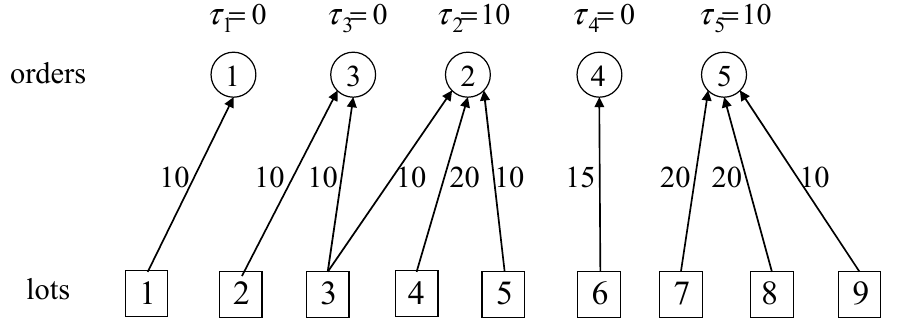
Figure 4. The optimal order-lot matching for Example 1